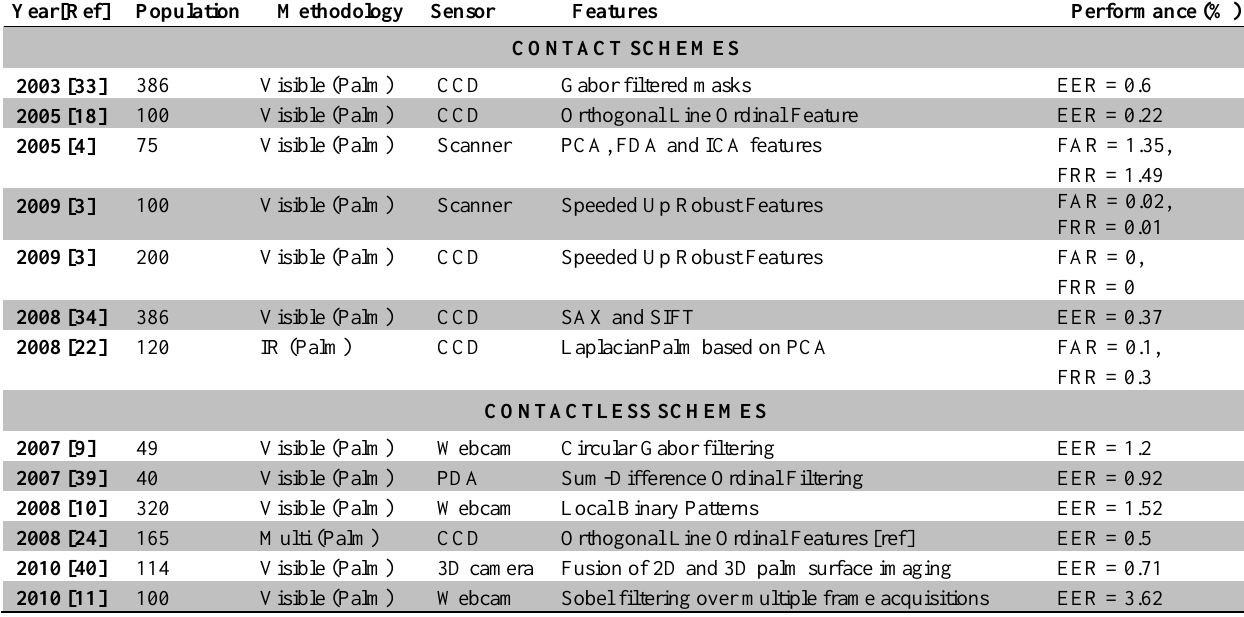
Table 2. Some examples of palmprint based biometrics